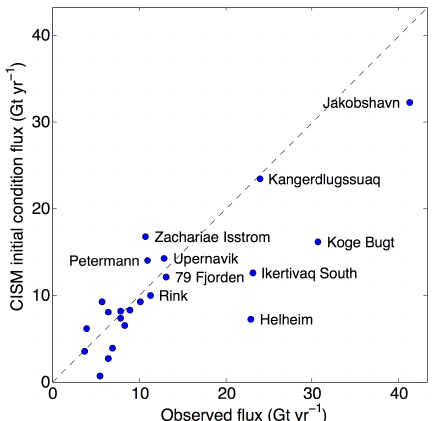
Figure 2. Observed outlet glacier flux from Enderlin et al. (2014) plotted against that from the model initial condition. Outlet glacier locations are marked in the right-hand panel of Fig.